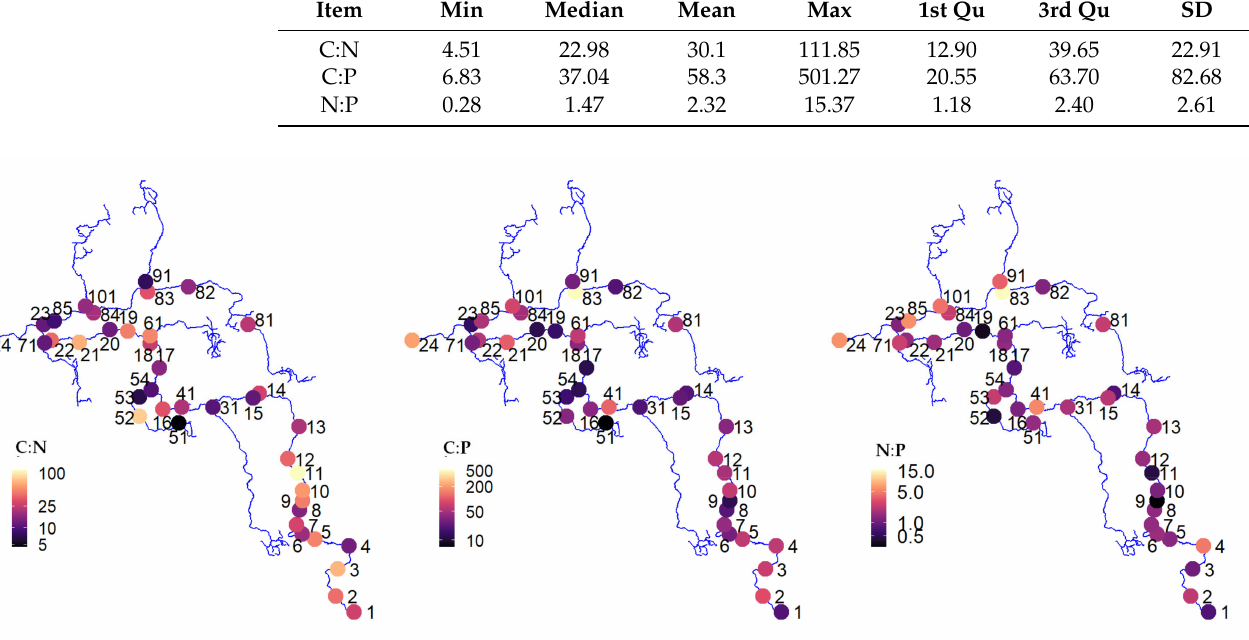
Figure 7. Spatial distribution of C:N, C:P and N:P ratios in the bottom sediments. C:P ratio values in bottom sediments of rivers of the Warta River catchment